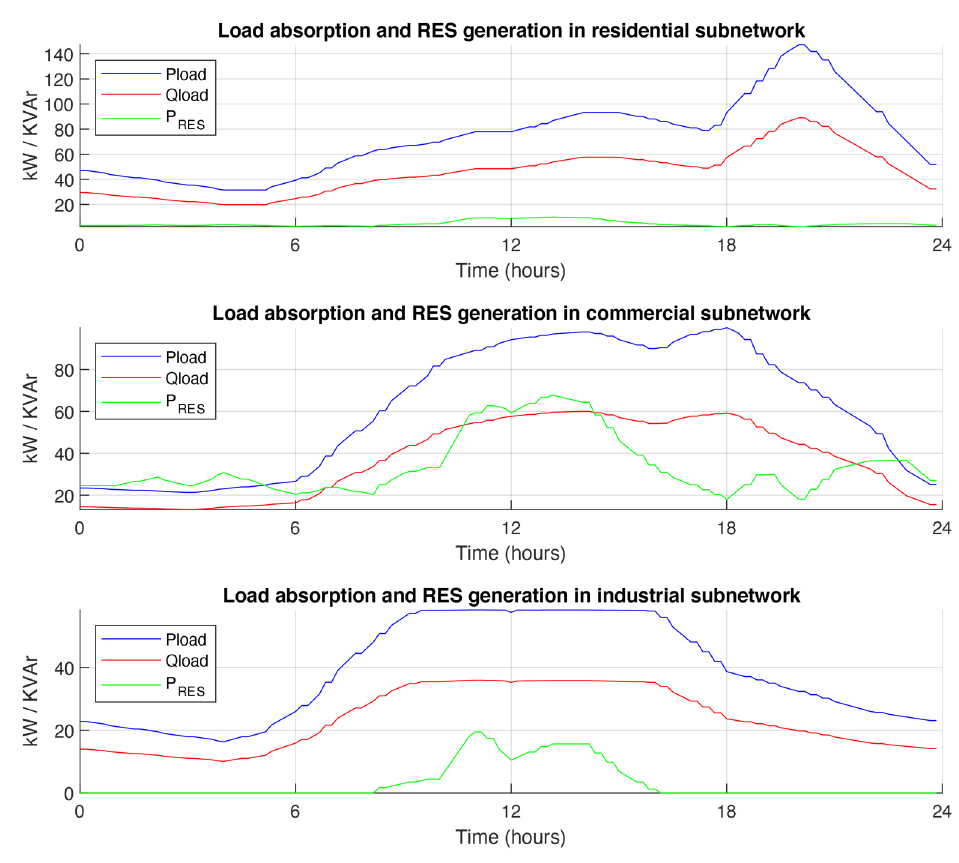
Figure 2. Typical 24 h power profiles of subgrids in Figure